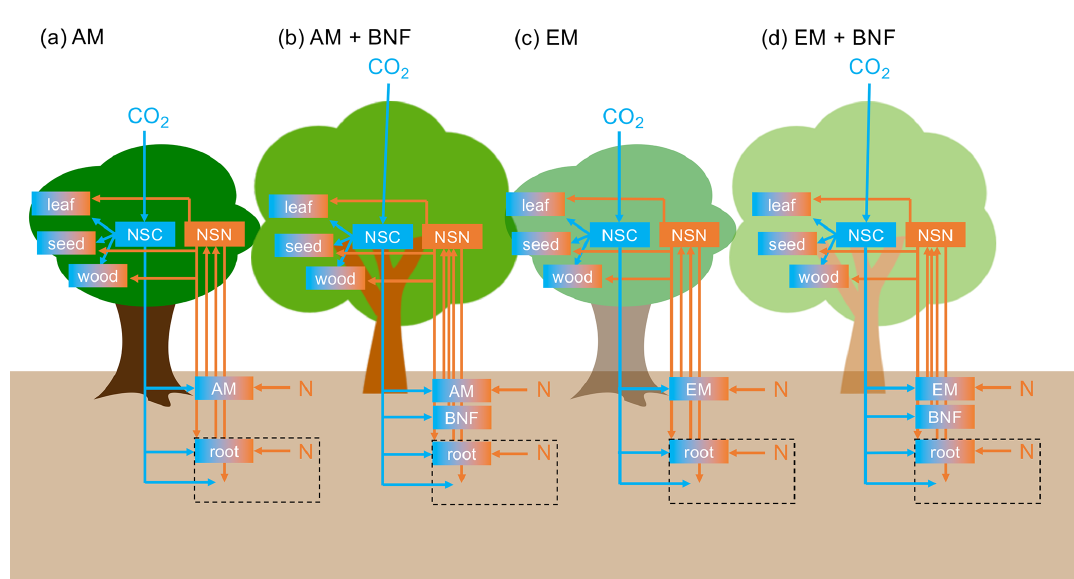
Figure 1. Diagram of key C and N pools (boxes) and fluxes (arrows). C pools and fluxes are indicated in blue. N pools and fluxes are indicated in orange. NSC represents non-structural C and NSN represents non-structural N. Orange and blue boxes have a fixed C : N ratio. Plant turnover, symbiont turnover, and soil C and N pools and fluxes are not displayed for visual clarity. The black dashed box represents the rhizosphere. (a) Vegetation type that associates with arbuscular mycorrhizae (AM). (b) Vegetation type that associates with AM and N-fixing bacteria. (c) Vegetation type that associates with ectomycorrhizae (EM). (d) Vegetation type that associates with EM and N-fixing bacteria.